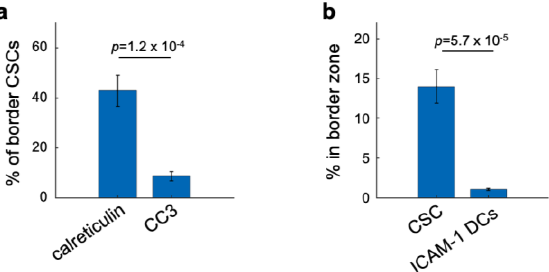
Figure 6. Functional cell events associated with the cancer stem cell niche. ( a ) Quantitative com- parison of the “eat me” signal, calreticulin, compared to the cell death signal, CC3, within the cancer stem cell (CSC) population in the panobinostat assay border zone. ( b ) Quantitative comparison of CSCs and ICAM-1-positive dendritic cell (DC) abundancy in the panobinostat border zone. Late-stage MMTV-PyMT tumors were implanted with panobinostat-loaded microdevices, and the drug was passively released for three days. n = 8 regions containing between 198 and 251 cells. Bars are means ± s.e.